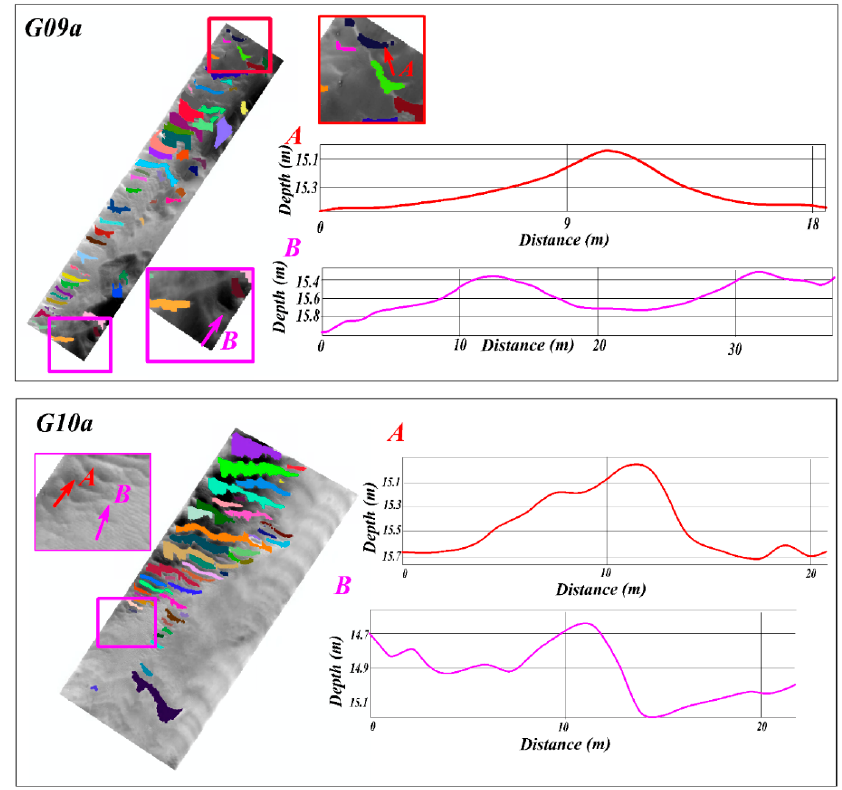
Figure 16. False negative of surfaces G09a and G10a. The arrows illustrate the profiles and their directions on the DBM. directions on the